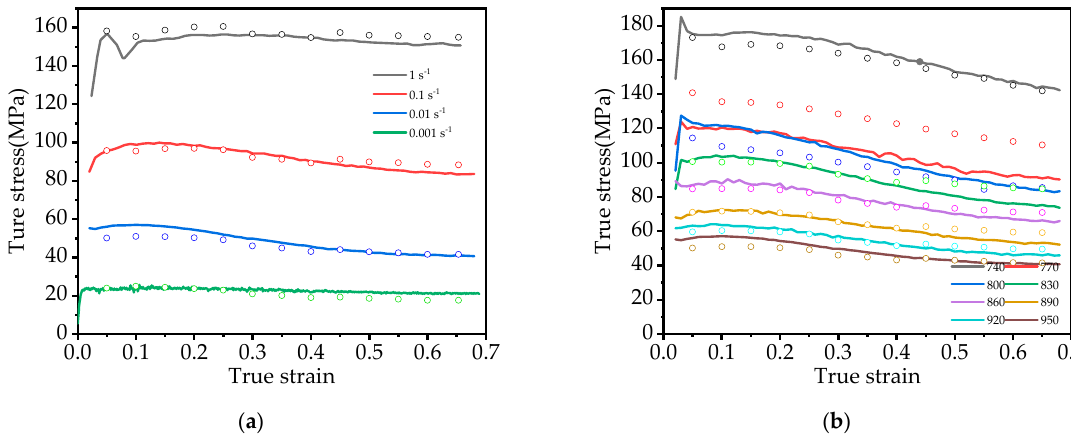
Figure 5. Comparison of the experimental and predicted stress under different strains of the Ti − 65541 alloy: ( a ) 950 ° C, and ( b ) 0.01 s − 1 .